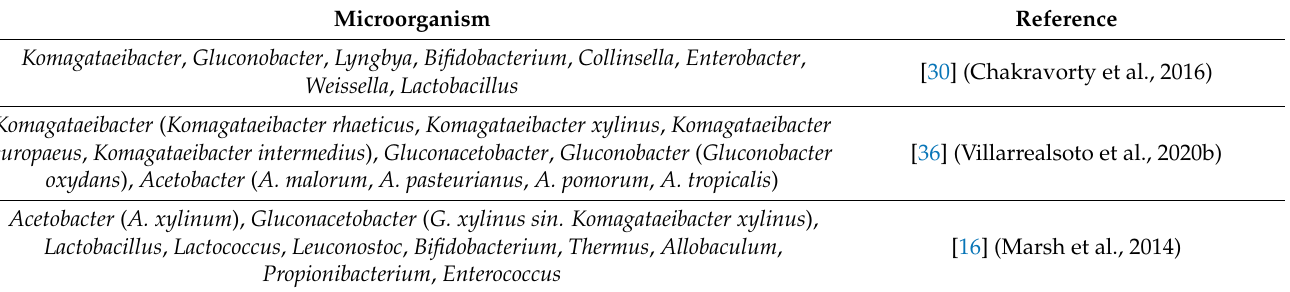
Table 1. Some genera and species of bacteria found in